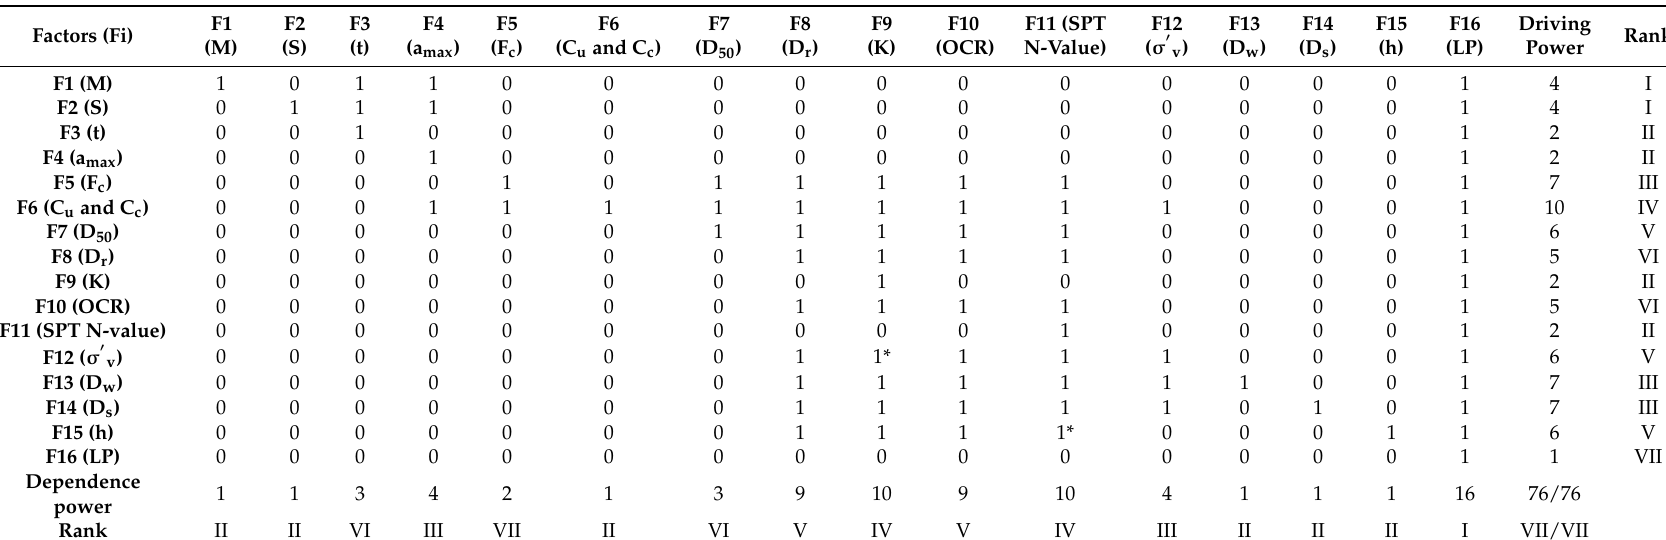
Table A2. Final reachability